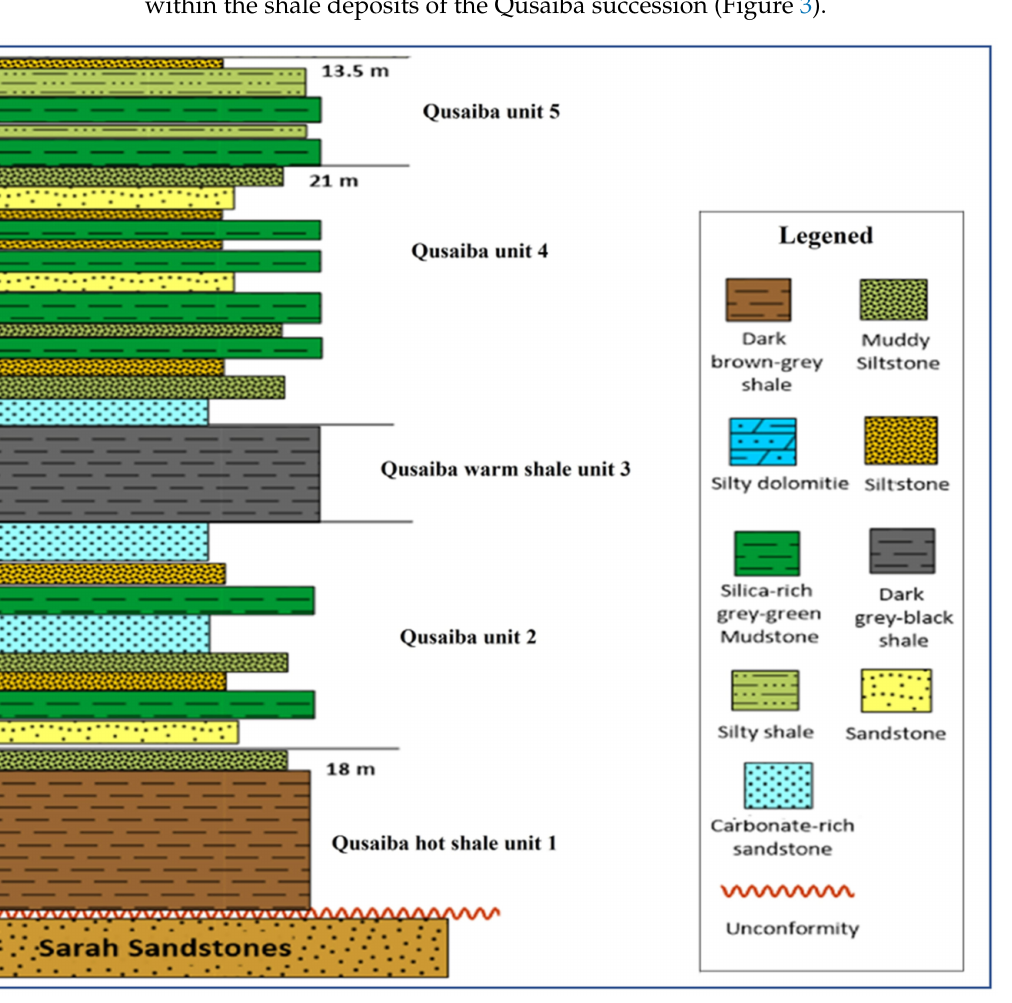
Figure 3. The lithostratigraphic classification of the Qusaiba Formation at Tayma